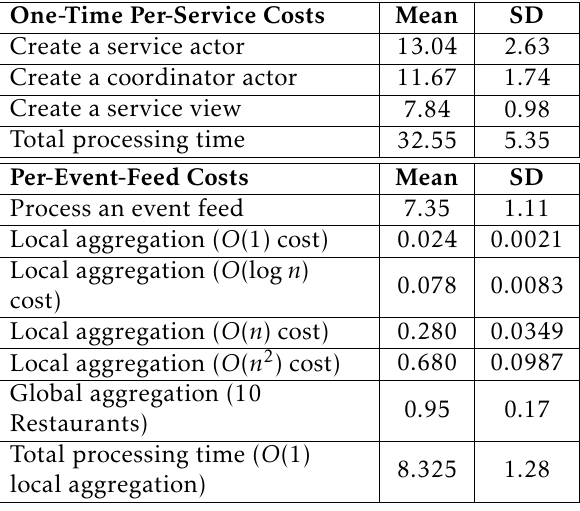
Table 4. Average Processing Time at the Client Side in ms